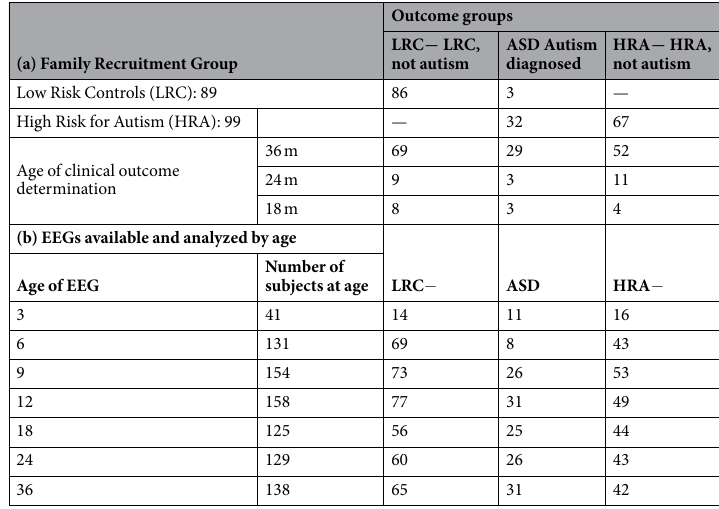
Table 1. The distribution of the 188 participants from each of the family recruitment groups is shown by (a) outcomes and (b) the number of EEG measurements available for analysis from each evaluation